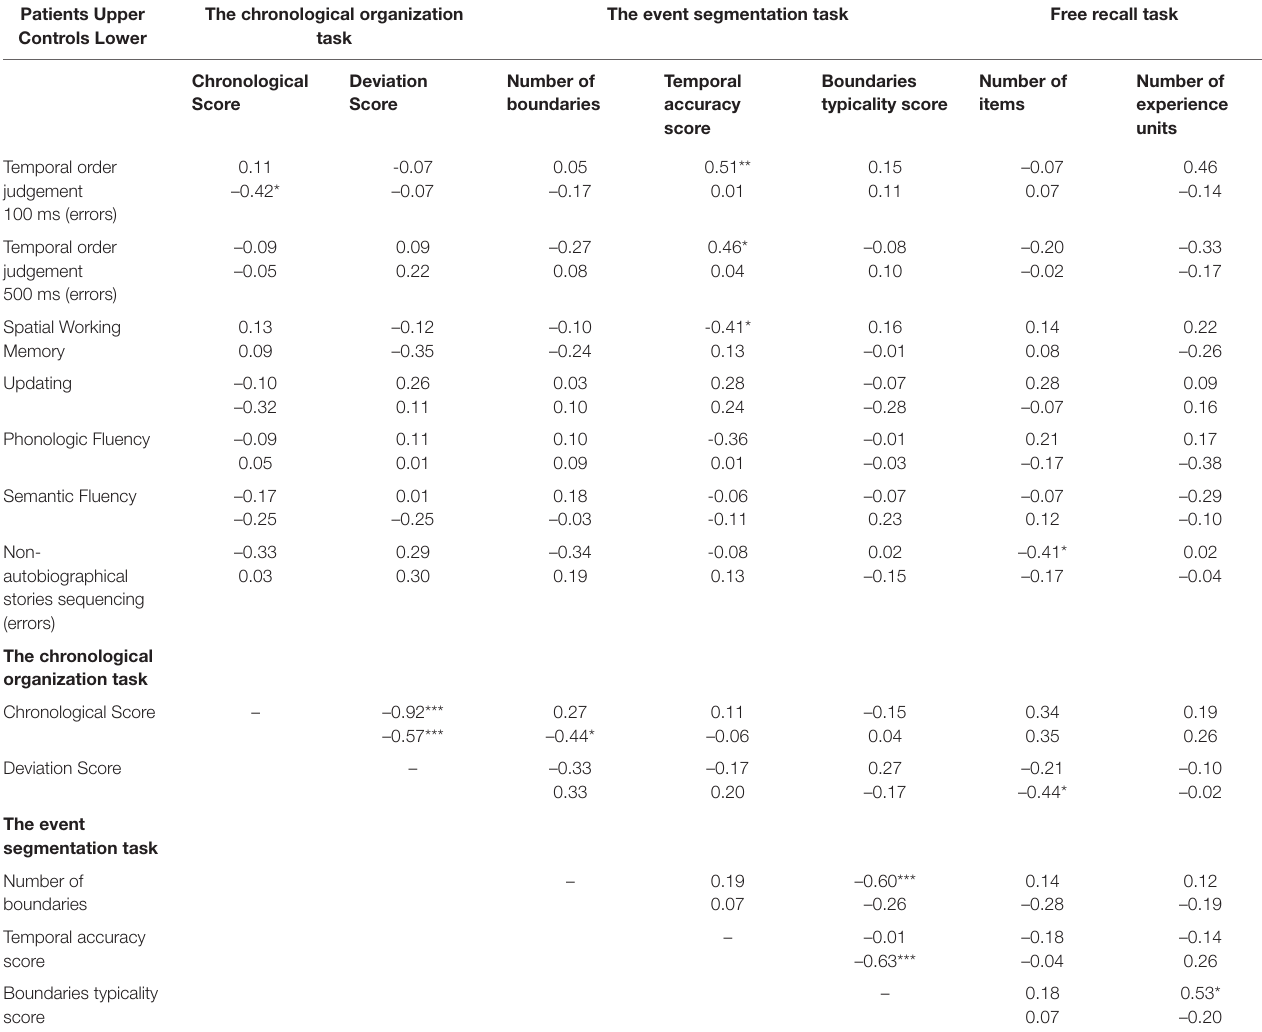
TABLE 4 | Correlation analyses between cognitive and autobiographical memory measures. Patients Upper Controls